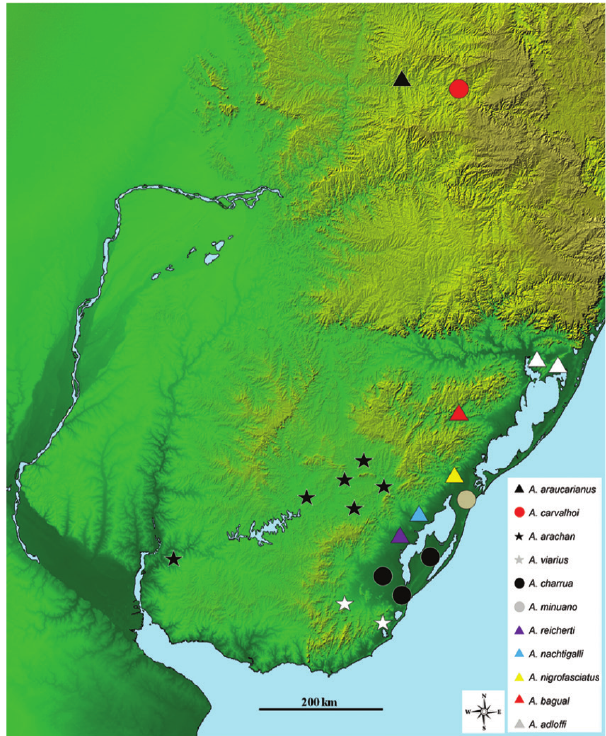
Fig. 13. Distribution map of the subgenus Acrolebias according to present phylogenetic analyses. Red dot = A. carvalhoi ; Black triangle = A. araucarianus ; Black star = A. arachan ; White star = A. viarius ; Black dot = A. charrua ; White dot = A. minuano ; Purple triangle = A. reicherti ; Light blue triangle = A. nachtigalli ; Yellow triangle = A. nigrofasciatus ; Red triangle = A. bagual ; White triangle = A. adloffi . Map modified from Shuttle Radar Topography Mission (SRTM), Courtesy